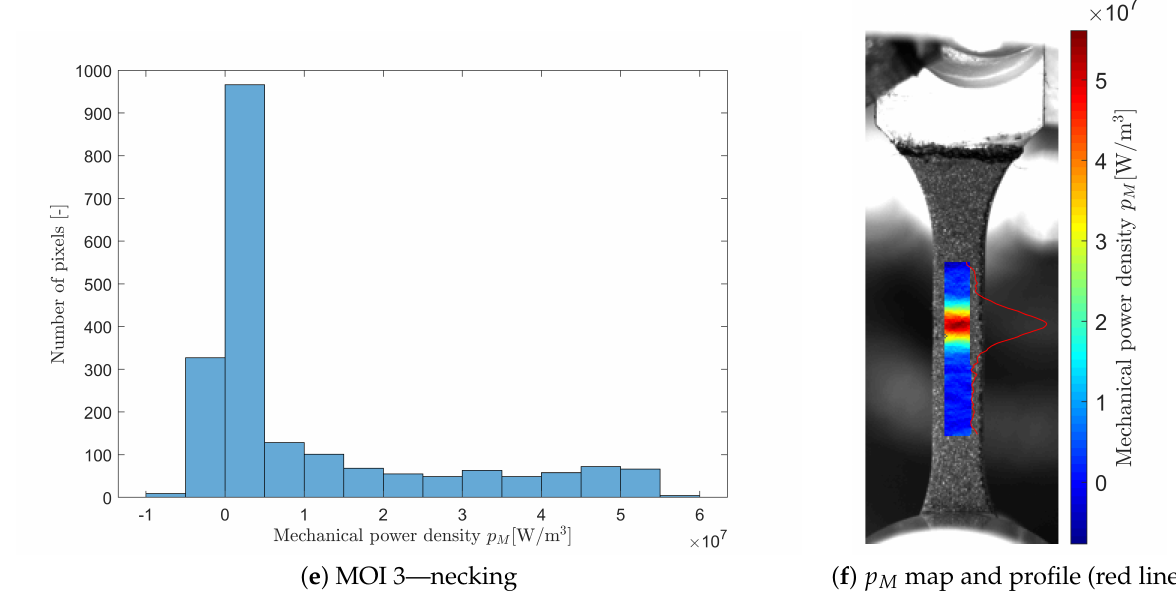
Figure 14. Distribution of the expended mechanical power density for the tensile test at three different points of interest indicated in Figure 13, corresponding to the initiation of the Lüders band ( a , b ), uniform deformation stage ( c , d ), and necking ( e , f